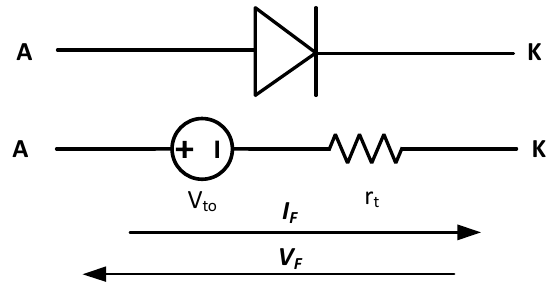
Figure 11. Diode symbol and equivalent model.